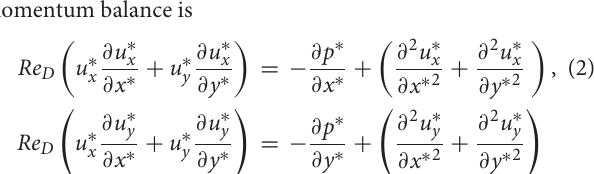
momentum balance